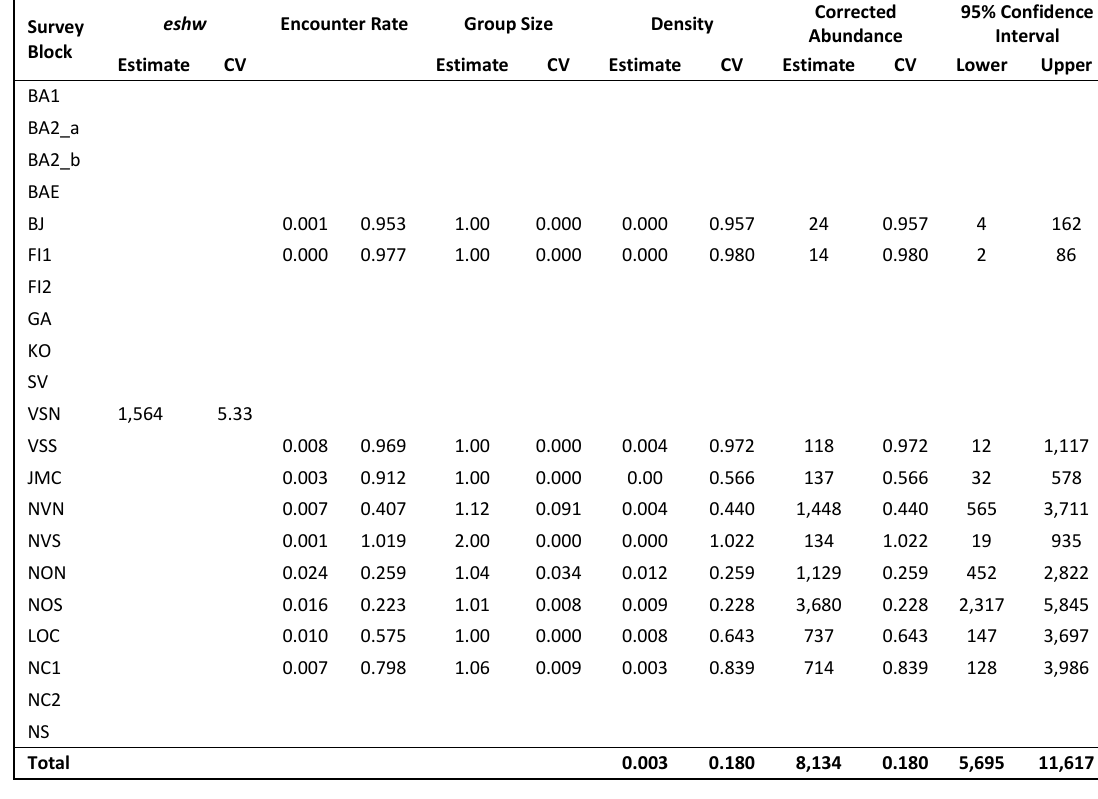
Table 8. Estimated density and abundance of sperm whales from the 2002 – 2007 survey (a) and the 2008 – 2013 survey (b). The eshw (effective search half width (m)) was estimated for the entire study region. Encounter rate, group size, density, abundance, and upper and lower confidence limits were estimated by block and corrected for perception bias, with the estimated p